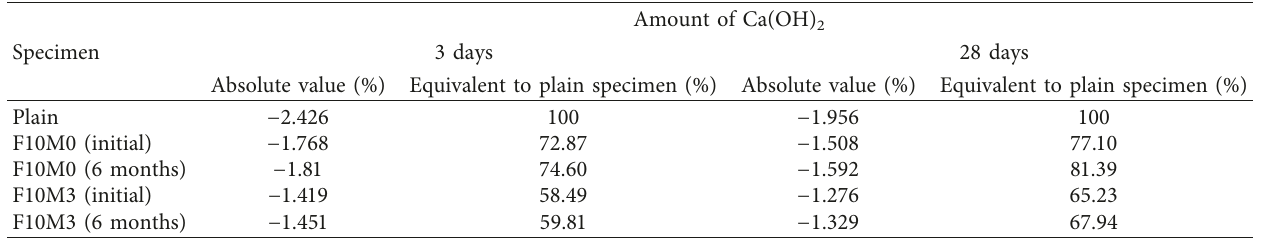
Table 11: Amount of Ca(OH)